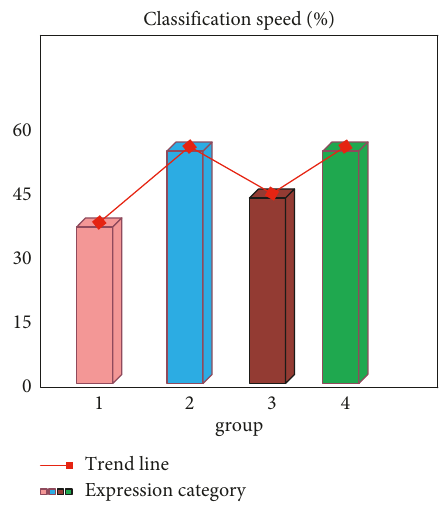
Figure 4: Data processing rate diagram of the system for ex- pressions with different complexity.